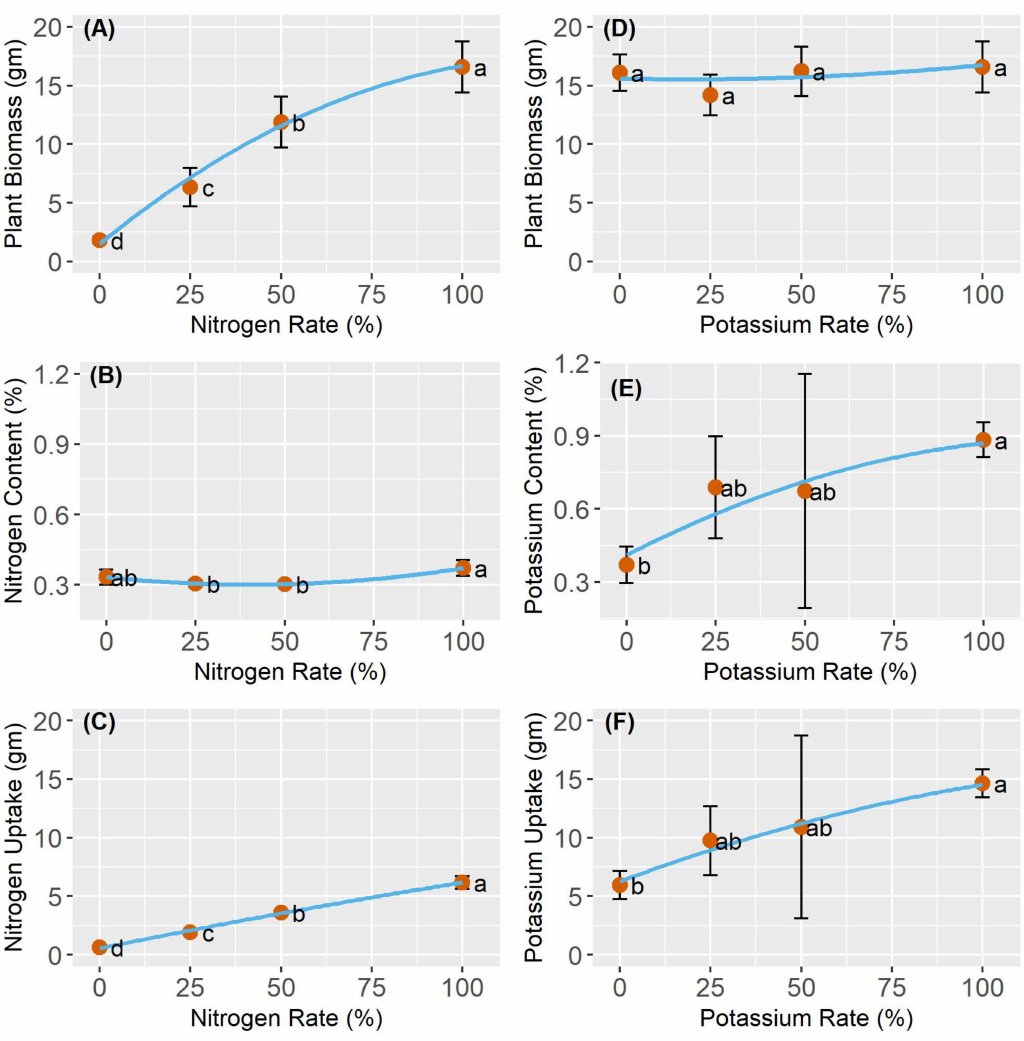
Figure 2. (Left panel) dried maize aboveground biomass ( A ), N content ( B ), and N uptake ( C ) as a function of di ff erent N rates and (right panel) dried maize biomass ( D ), K content ( E ), and K uptake ( F ) as a function of di ff erent K rates. Samples were collected 36 days after emergence (V6 crop growth stage). Error bars represent confidence intervals ( α = 0.05), and fitted curves are quadratic polynomials. Coe ffi cients of determination (R 2 ) are indicated on each